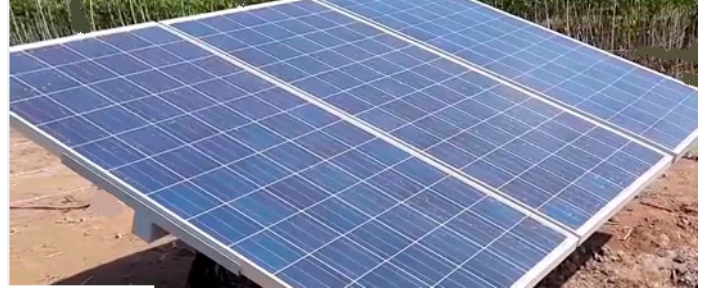
Figure 5. Established solar panels.